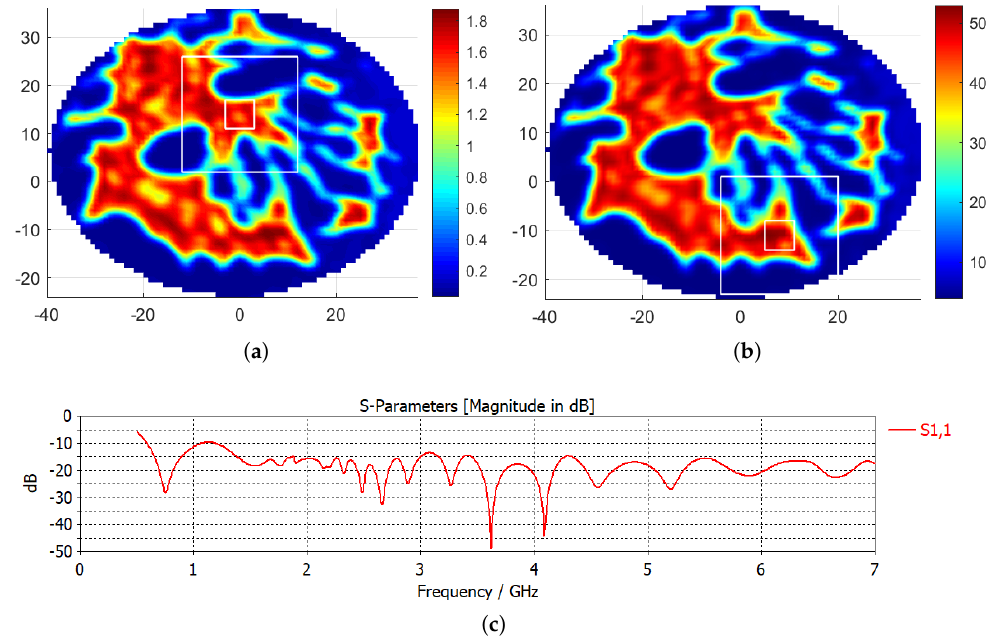
Figure 1. Dielectric properties of the central slice of the breast with tumor: ( a ) electrical conductivity (S/m), ( b ) relative permittivity (the axes are in mm). White squares on the conductivity graph indicate the target region (inner) and the healthy region (outer) boundaries for the target (0, 14, 0) mm, and white squares on the permittivity graph indicate the boundaries for the target (8, − 11, 0) mm. ( c ) |S11| (dB) vs. frequency graph of the Vivaldi